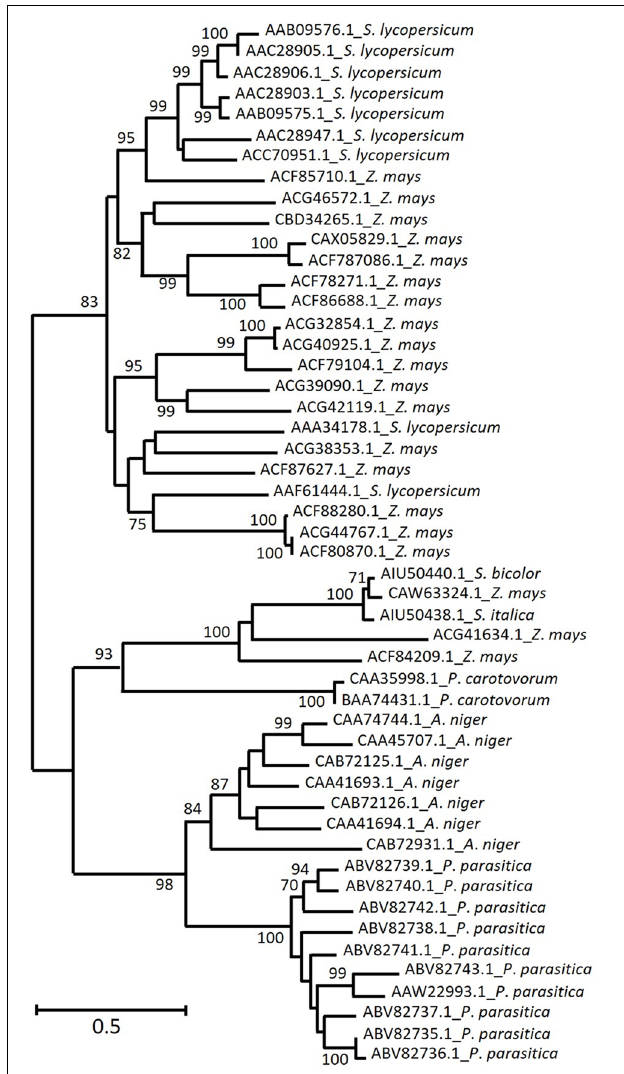
FIGURE 2 | Homology of deduced amino acid sequences from the most represented plant and microbe EPG among the characterized enzymes from CAZy GH28. Predicted EPGs from grasses ( Setaria italica , Sorghum Bicolor , and Zea mays – not yet characterized) were added to the alignment. The arabic numbers indicate bootstrap values and phylogenetic groups identified, respectively. The maximum likelihood tree was chosen accordingly to the highest ranked substitution model (Tajima-Nei) and 1000 bootstrap replications. NCBI GenBank numbers are indicated in each